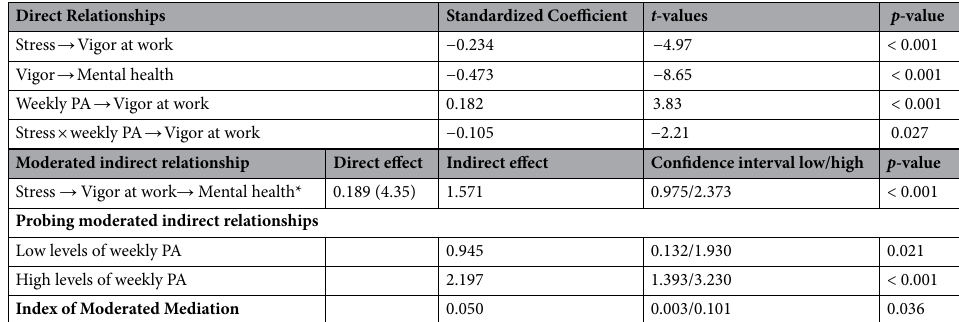
Table 2. Test for Moderated Mediation Using 95% Confidence Interval. * = The indirect effect is moderated by the construct of weekly PA. Standardized Coefficient reported. Value in parentheses is t-value. Bootstrap Sample =